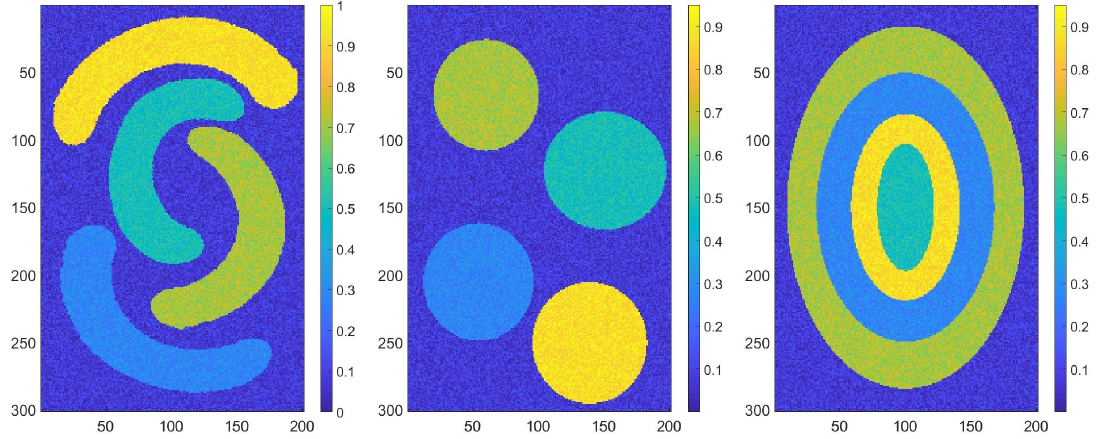
Figure 2. Synthetic data sets.